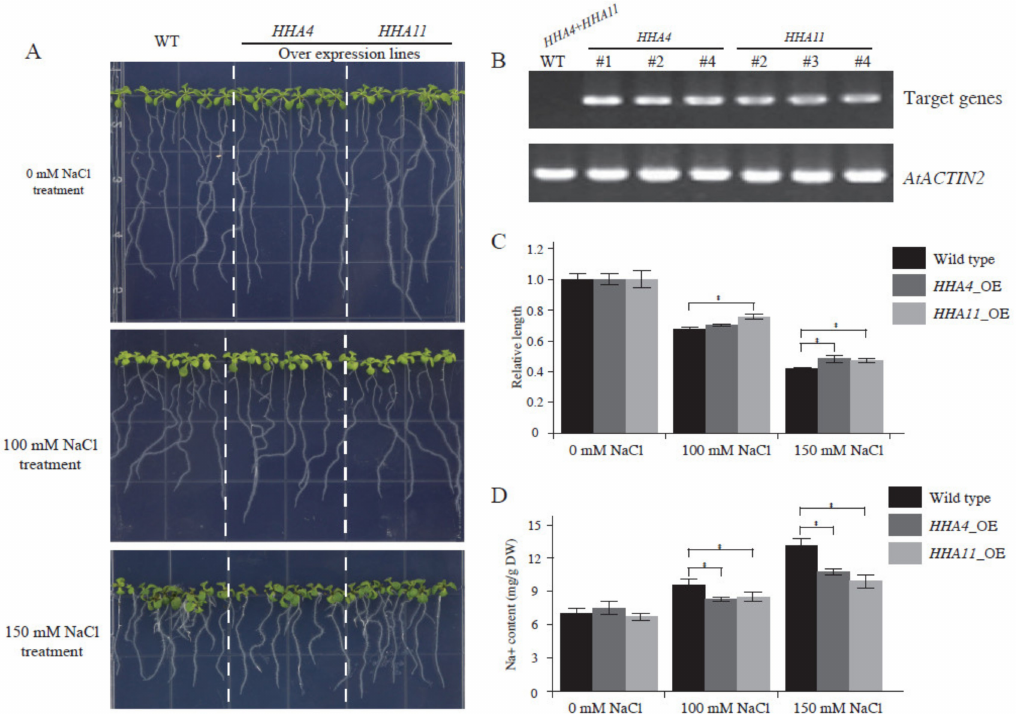
Figure 8. The phenotypes of transgenic Arabidopsis with HHA4 and HHA11 under NaCl stresses. The phenotypes of 2-week-old transgenic Arabidopsis with HHA4 and HHA11 treated with 100 mM and 150 mM NaCl ( A ); the expression level identification of HHA4 and HHA11 in Arabidopsis transgenic plants by semi-quantitative PCR ( B ); the main root length of transgenic plants under salt stress ( C ). Ten seedlings of transgenic lines and control plants were used to record the main root length, and the root length data were analyzed with the ANOVA method using the SPSS software (* p < 0.05); Na + content of transgenic plants under salt stress ( D ). The statistical result was analyzed with the ANOVA method using SPSS software (* p <